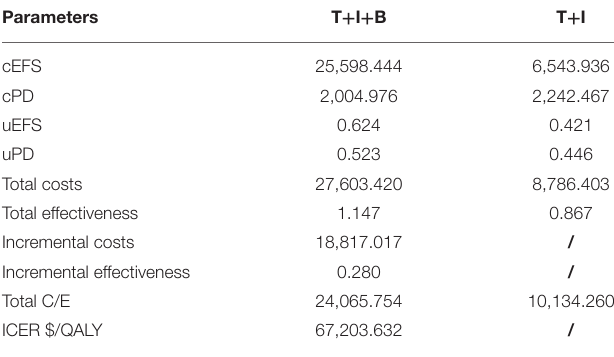
TABLE 2 | The results of the cost-effectiveness